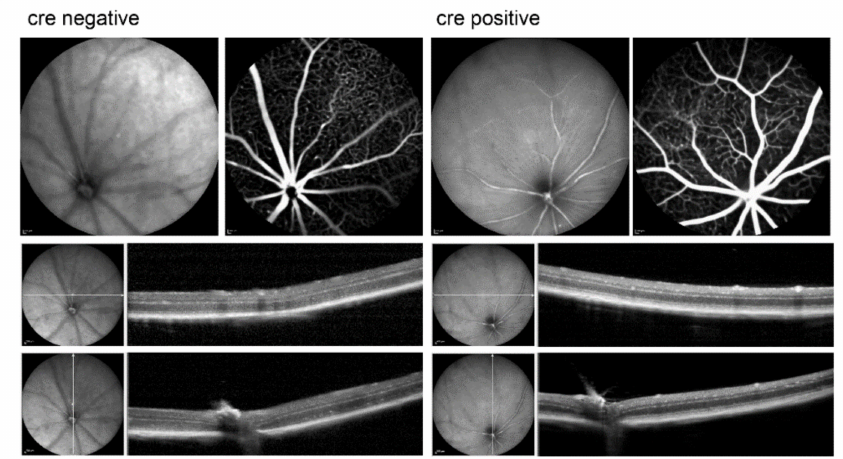
Figure 7. Examples of in vivo imaging of Cre-negative mice (controls) and Cre-positive mice (knock- outs) as indicated. On top, images are shown obtained by infrared scanning laser ophthalmoscopy ( left ) and fluorescein angiography ( right ). Below, optical coherence tomography images are shown, with both horizontal and vertical scans.